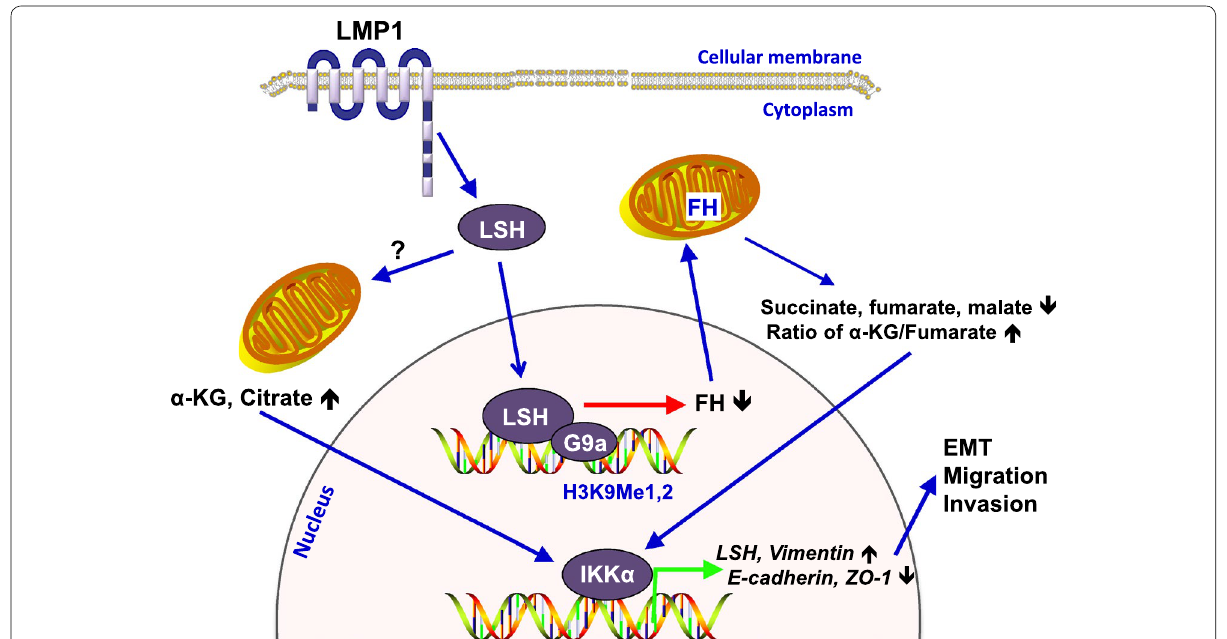
Fig. 1 Schematic model of lymphocyte‑specific helicase (LSH) in cancer progression. LSH promotes cell growth, migration, and invasion, which are characteristics of cancer progression. The effect of LSH is, in part, mediated by fumarate hydratase (FH), through the intact combination of LSH and euchromatic histone‑lysine N‑methyltransferase 2 (G9a). FH repression, in turn, leads to changes of tricarboxylic acid cycle (TCA) intermediates, including succinate, fumarate, and malate, and an increase in the ratio of α‑ketoglutarate (α‑KG) to fumarate. TCA intermediates promote migration, invasion, and epithelial–mesenchymal transition (EMT) through the decrease of E‑cadherin and tight junction protein ZO‑1 and the increase of vimentin. The changes of E‑cadherin and ZO‑1 are mediated by inhibitor of nuclear factor kappa‑B kinase alpha (IKKα), which directly binds to these